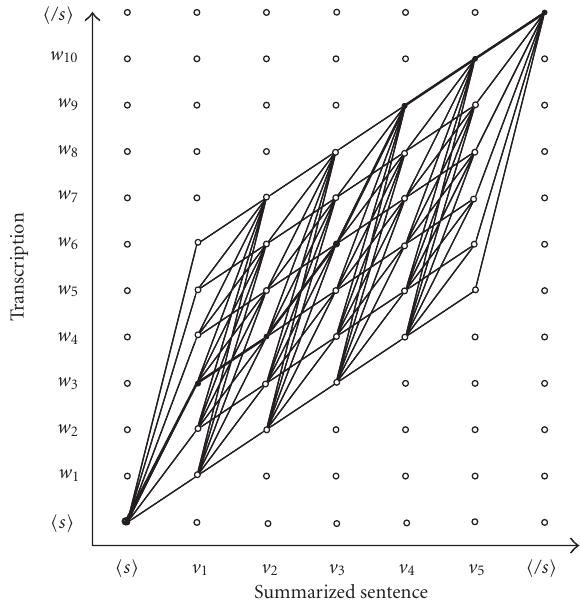
Figure 5: Example of DP alignment to summarize an individual utterance.